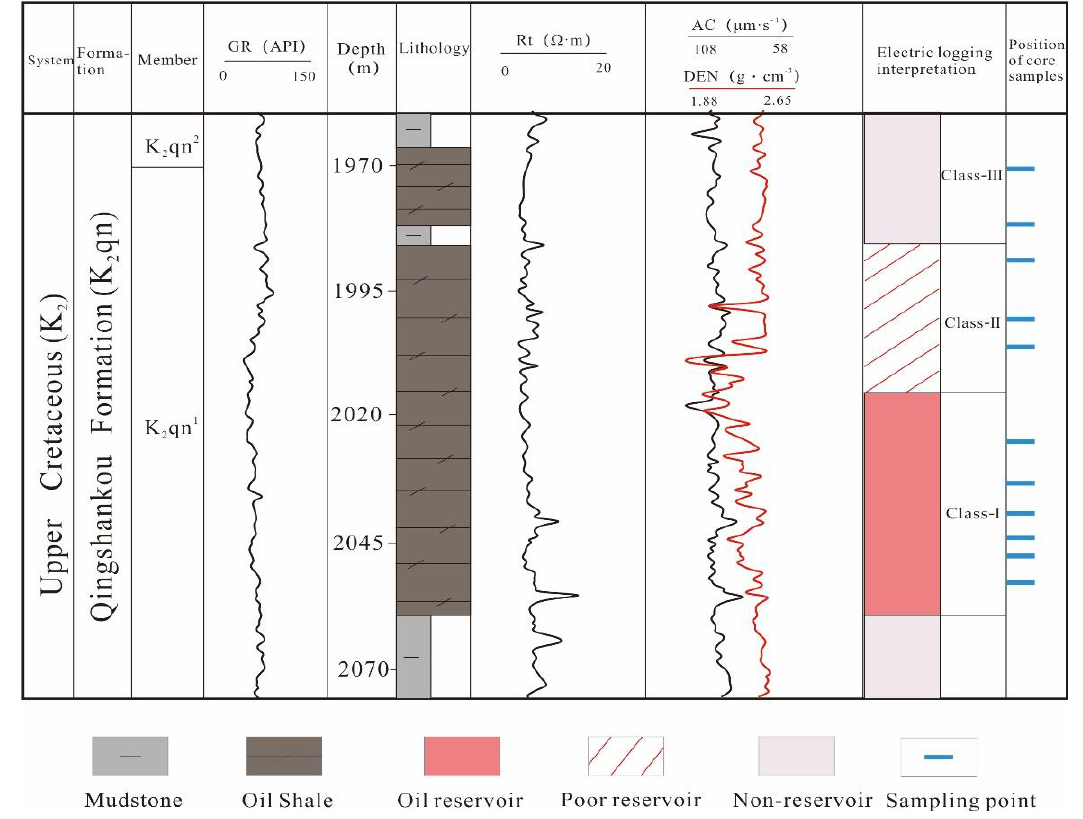
Figure 2. Logging interpretation and sampling positions in Well A of Da’an area, southern Songliao Basin. Table 1. TOC and XRD results of the samples from K 2 qn 1 Member.